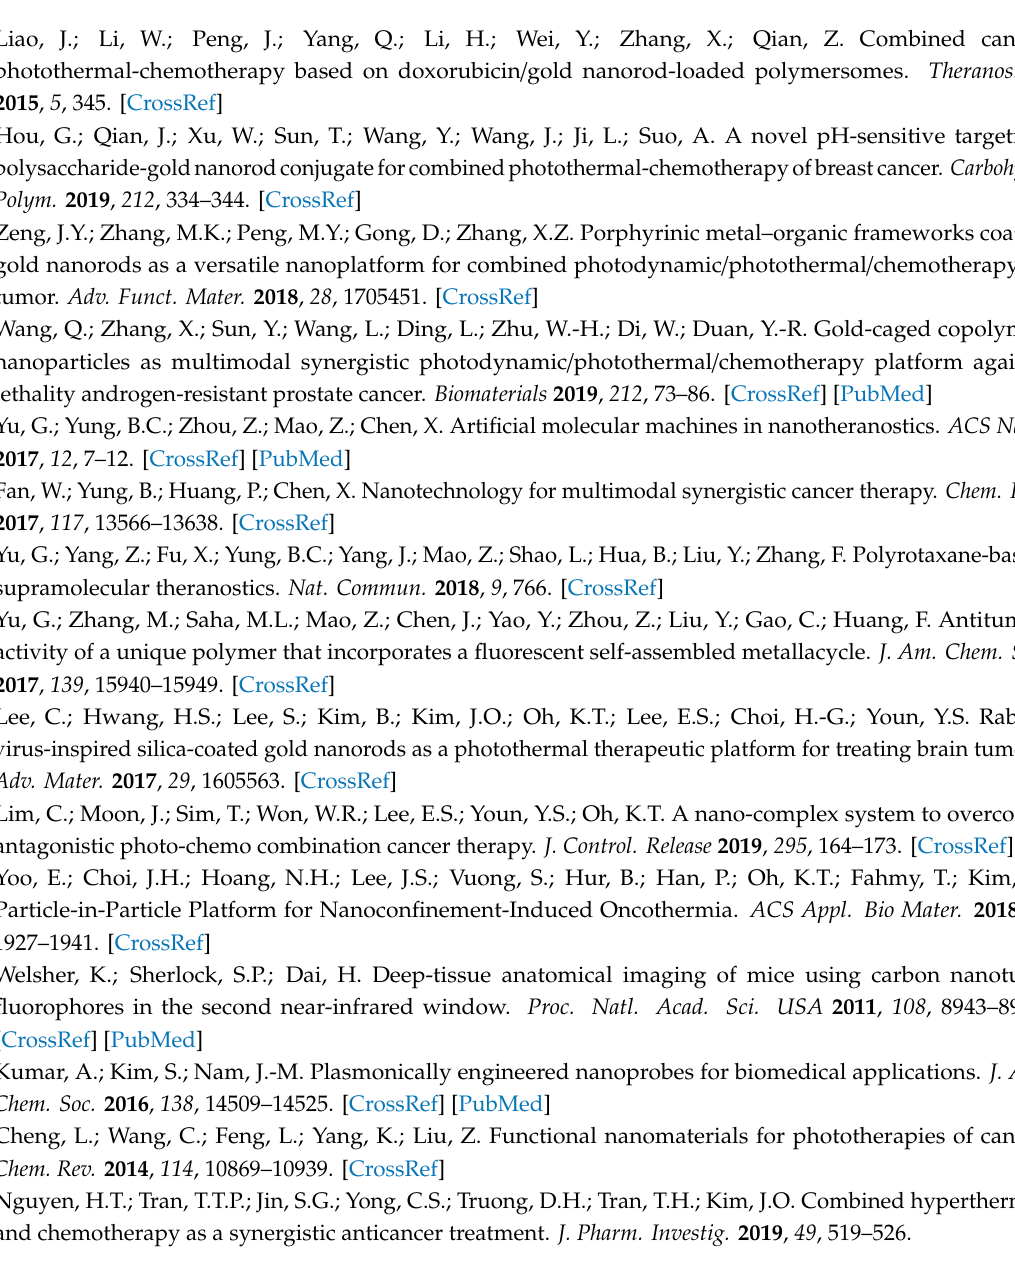
Figure S1: Chemical synthesis route and structural analysis of Poly(Asp- g -Im)-PEG (PAIM-PEG) by 1 H-NMR analysis. Figure S2. Solubility of Doxorubicin (DOX) in PBS at pH 7.4 and 6.5. Figure S3. in vivo photothermal e ff ect at the tumor site by the irradiation of NIR laser (808 nm, 1 min, 2 W / cm 2